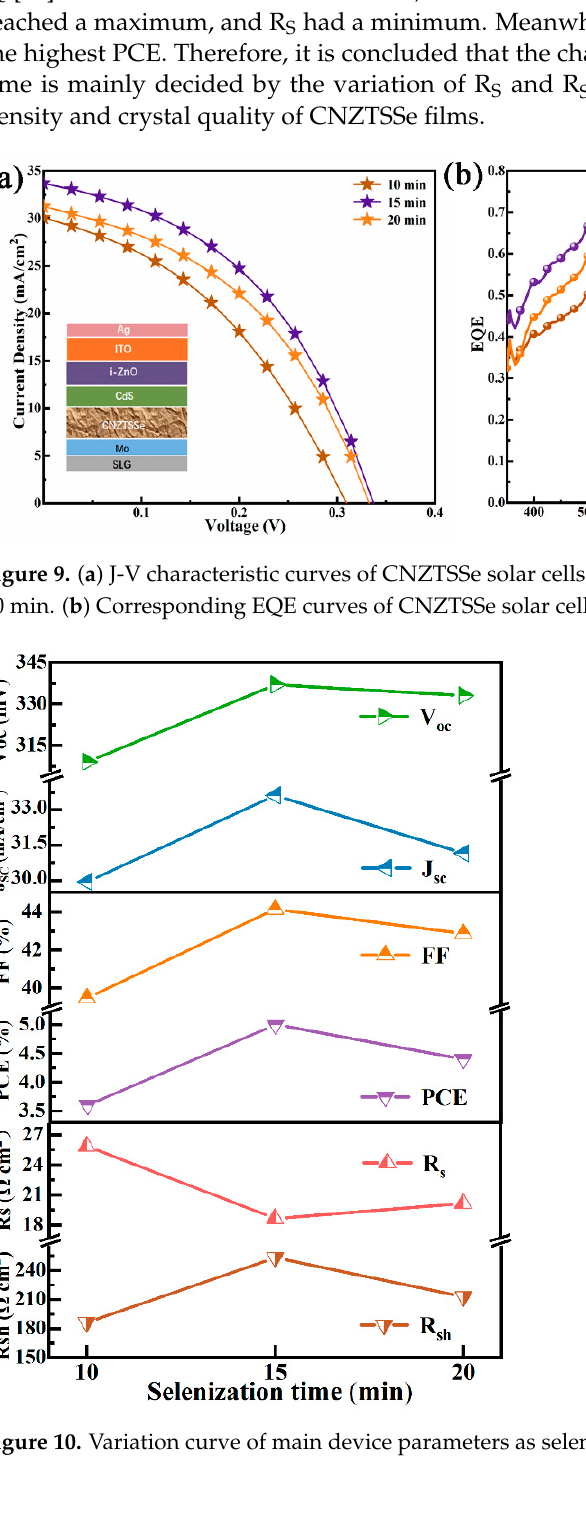
Table 3. The main photovoltaic parameters of CNZTSSe solar cells were prepared at the selenida ‐ tion time of 10, 15, and 20 min.